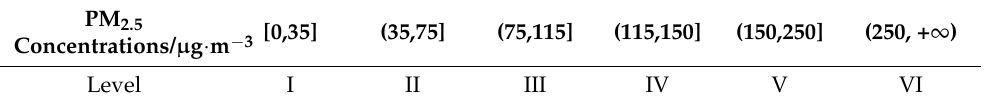
Table 5. The ambient air quality levels and the corresponding concentration